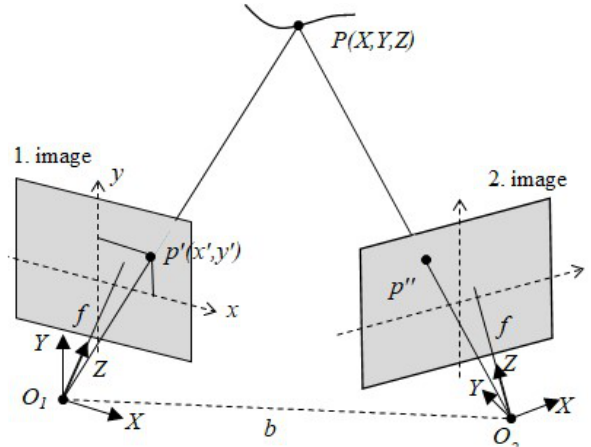
Figure 3. Stereo image triangulation